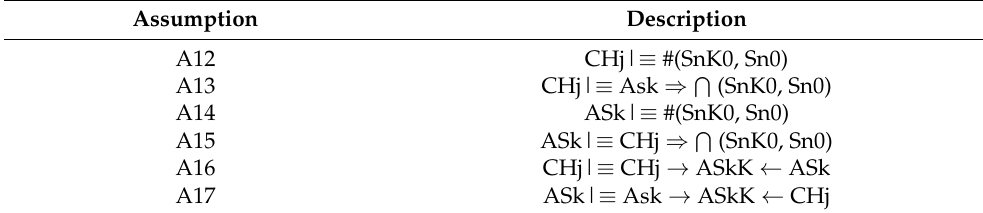
Table 8. Assumptions of the authentication phase of agriculture